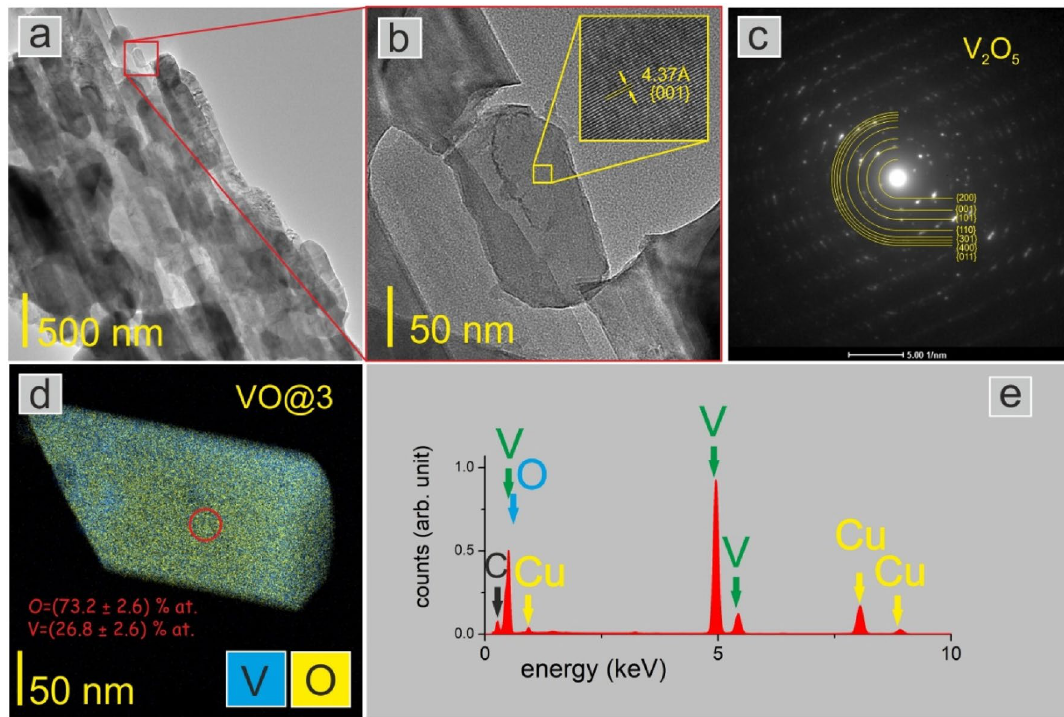
Figure 5. ( a )TEM image of the polycrystalline nanorod-like structure of VO@3, ( b ) a single nanograin with an inset showing the crystalline structure of the grain, ( c ) an electron diffraction pattern, analysis confirmed the orthorhombic structure for all samples, ( d ) EDX map of a single VO@3 nanograin, chemical analysis confirmed the stoichiometry of the V 2 O 5 compound, ( e ) EDX spectra collected from the area of the red circle marked on the grain in ( d ). The presence of Cu and C is related to the substrate, a carbon film supported on a copper